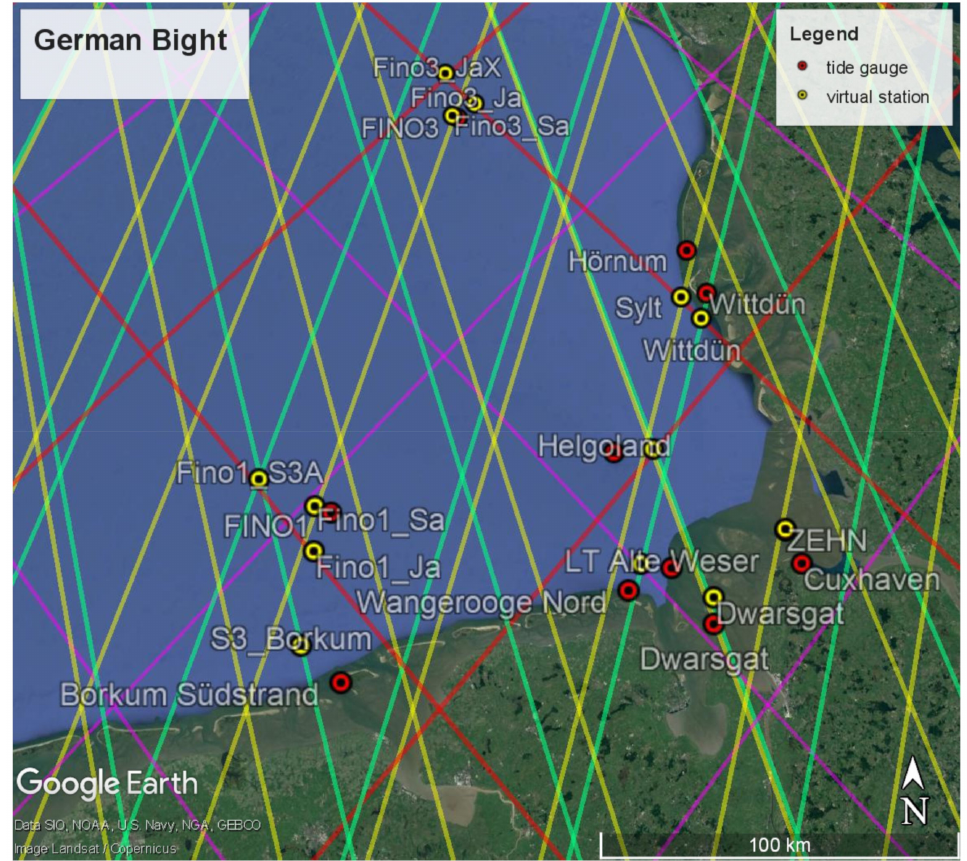
Figure 1. Positions of virtual altimetry (yellow), tide gauge (red) stations and ground tracks during exact repeat periods for Jason in standard (red) and interleaved phases (purple), Envisat/Saral (yellow) and Sentinel-3A